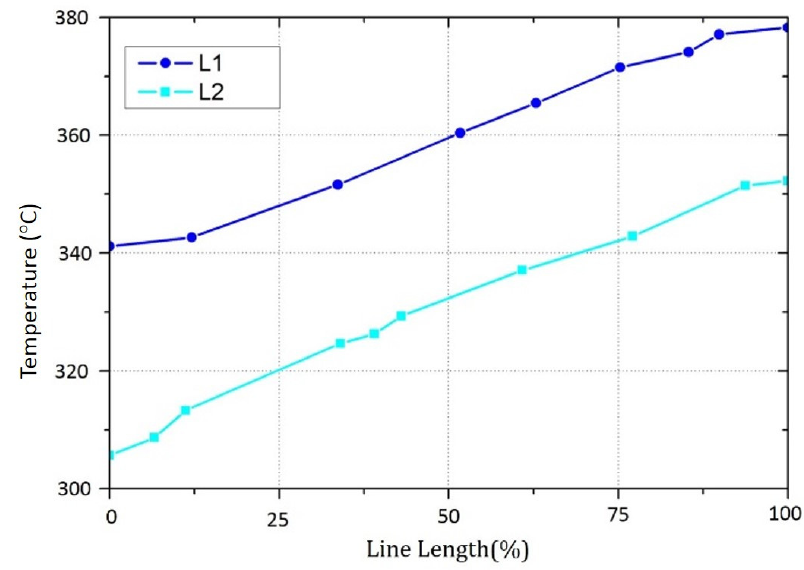
Figure 11. Turbine hosing’s heat transfer distribution diagram.